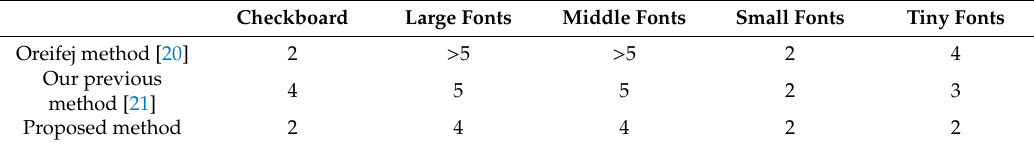
Table 3. The number of iterations when termination conditions are